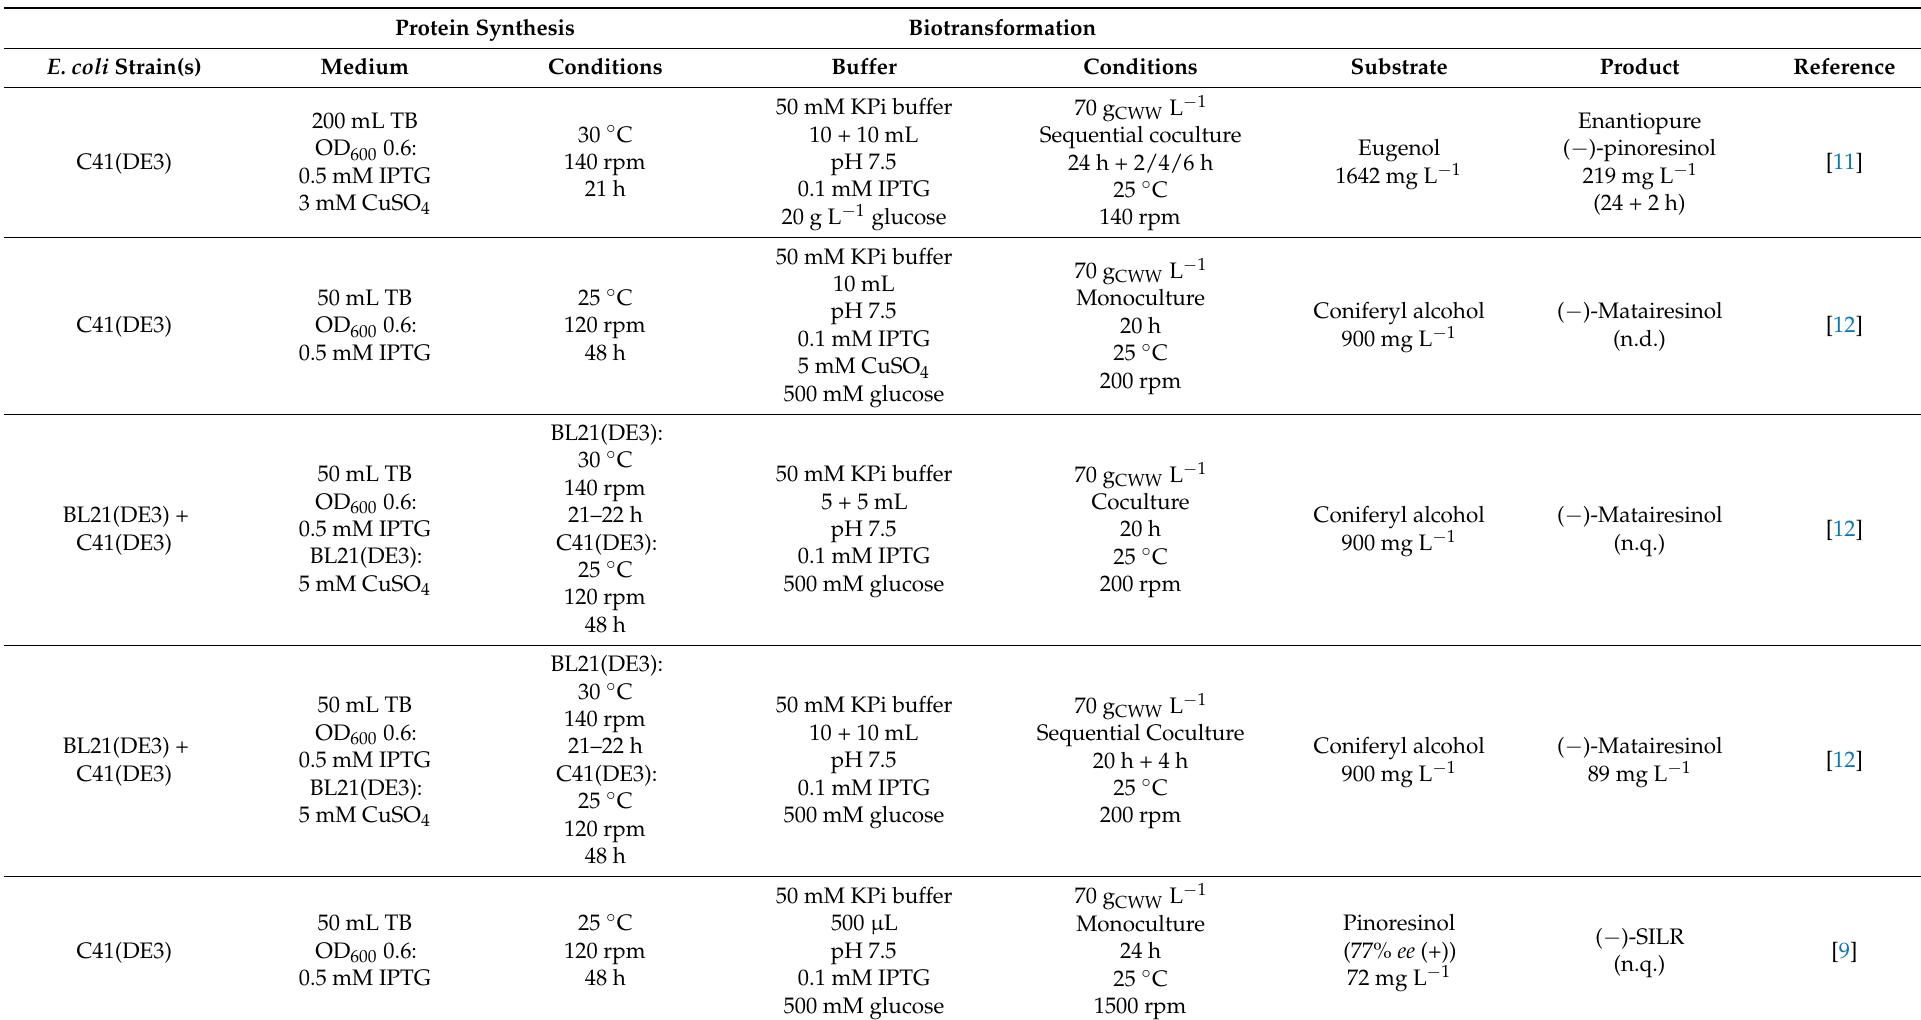
Table 1. Literature reported resting-cell biotransformations with Escherichia coli ( E. coli ) forming secoisolariciresinol (SILR) as an intermediate or (by)product. Protein